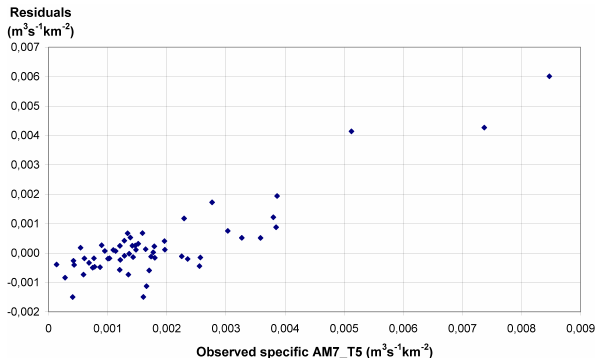
Fig. 1. Plot of global model residuals against observed specific AM7 T (example for the return period of 5yr). Residuals increase linearly with observed specific AM7 T .